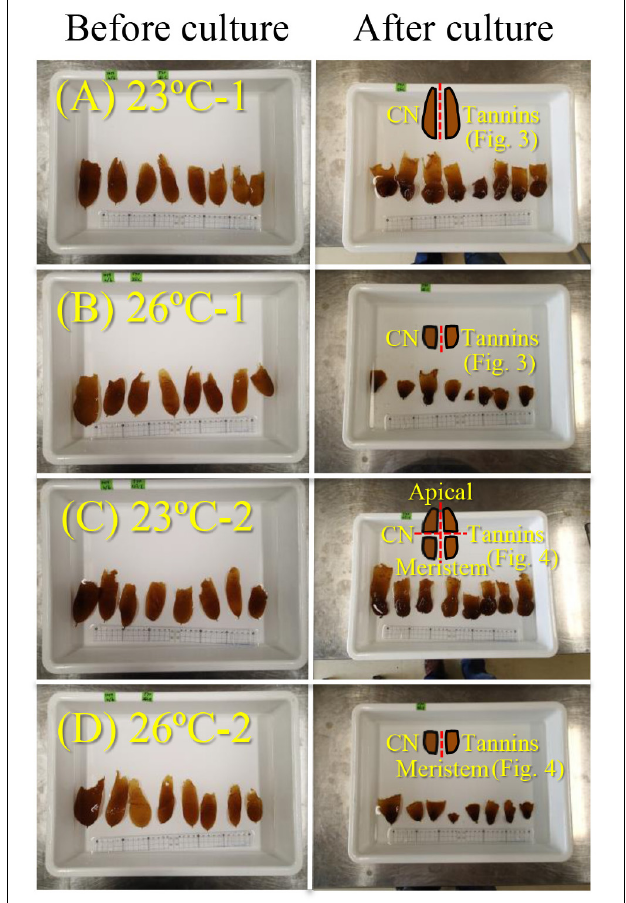
FIGURE 1 | Photographs of E. bicyclis juvenile sporophytes before and after culture at 23 ◦ C (A,C) and 26 ◦ C (B,D) , with illustrations showing the cutting methods (red dotted line) for the chemical composition measurements in experiment 2. All kelps (A–D) were cut in half (right and left) and each half was used to measure carbon and nitrogen (indicated as “CN”), and phlorotannin contents (indicated as “Tannins”) within whole sporophytes. Eight kelps cultured at 23 ◦ C (C) were also cut into upper and lower parts (i.e., apical and meristems, respectively) at the center of the BL in order to measure the chemical compositions separately. Results of the measurements are shown in Figures 3 , 4 .